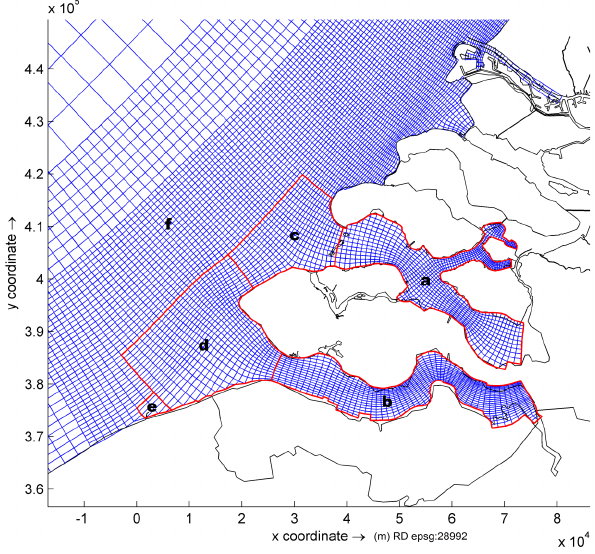
Figure 1. Model grid of the Delft model in blue and definition of the areas in red. (a) eastern Scheldt estuary, (b) western Scheldt estu- ary, (c) eastern Scheldt mouth, (d) western Scheldt mouth, (e) Zee- brugge harbour area and (f) southern North